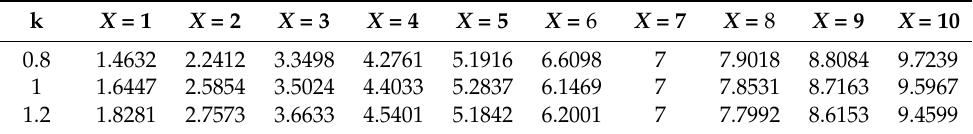
Table 4. Dependence of the value of the function f m ( X ) on the expert error k and the grade X in case 4, when σ = 1, µ = 7.